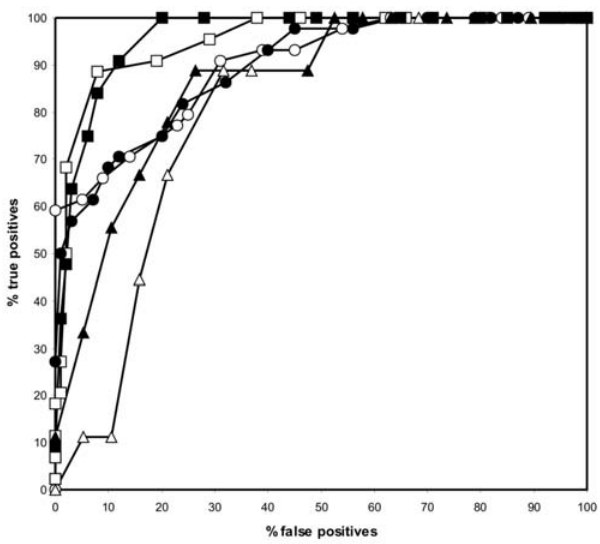
Figure 4. ROC curves representing the performance of the different predictors before learning set optimization. The graph visualizes the not cross-validated sequence-based predictor (open square), the not cross-validated sequence and structure-based predictor (closed square), the cross-validated sequence-based predictor (open circle), the cross-validated sequence and structure-based predictor (closed circle), the sequence based predictor on the independent validation set (open triangle) and the sequence and structure-based predictor on the independent validation set (closed triangle).